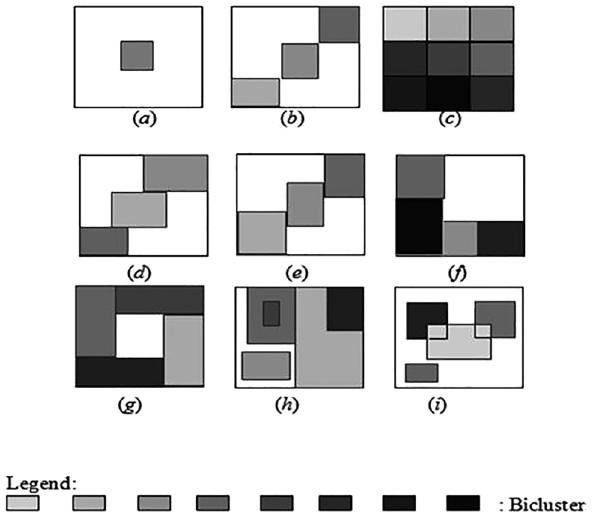
Figure 3: Types of groups of biclusters